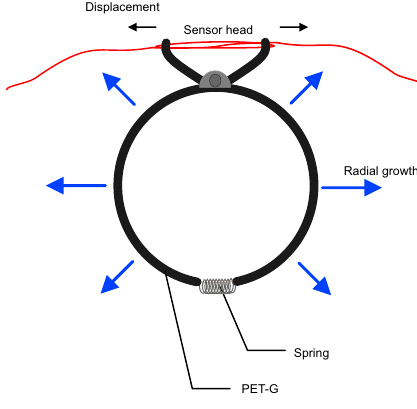
Figure 2. Schematic of the experimental piece.